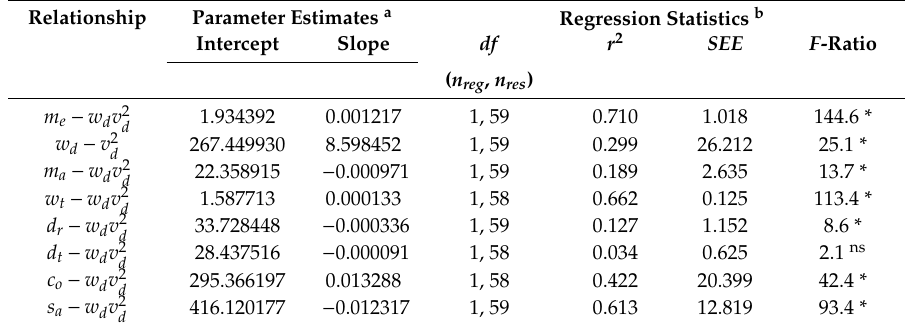
Table 4. Parameter estimates and statistics for the attribute—acoustic velocity regression relationships (Equations (5a) and (5b)).